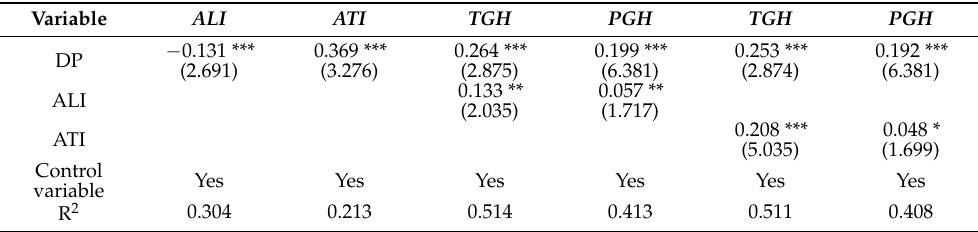
Table 10. Regression results of the intermediary effect